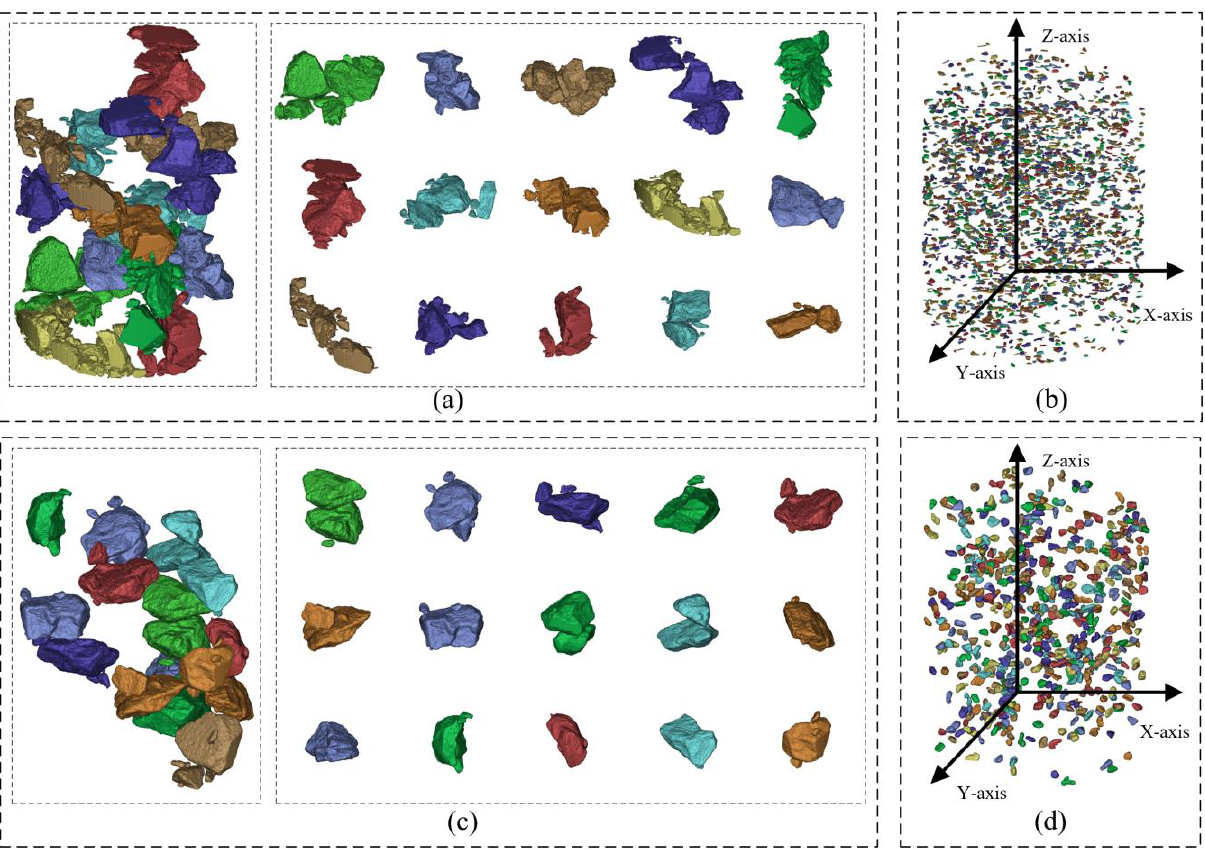
Figure 16. Aggregate extraction results for the 3D voxel model: ( a ) large volume aggregates without considering the similarity of aggregate phase geometry between adjacent slices (Figure 10a); ( b ) small volume aggregates without considering the similarity of aggregate phase geometry between adjacent slices (Figure 10a); ( c ) large volume aggregates considering the similarity of aggregate phase geometry between adjacent slices (Figure 10d); ( d ) small volume aggregates considering the similarity of aggregate phase geometry between adjacent slices (Figure 10d).